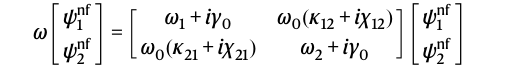
eigenmode ( ψ nf ) at 3.655GHz on the XY (left) and XZ (right) planes. c The E z component of the surface wave ( ψ p ) on the XZ plane. d The dispersions of the surface wave (red) in the background, and the light line (blue) in the air. The leaky waveslieinthegrayregion. e Thedistance-dependentstrengthofcalculateddirect coupling κ (blue)andindirectcouplings χ e (magenta)and χ o (red).Theinsetsdepict the mode-parity modulation on leaky